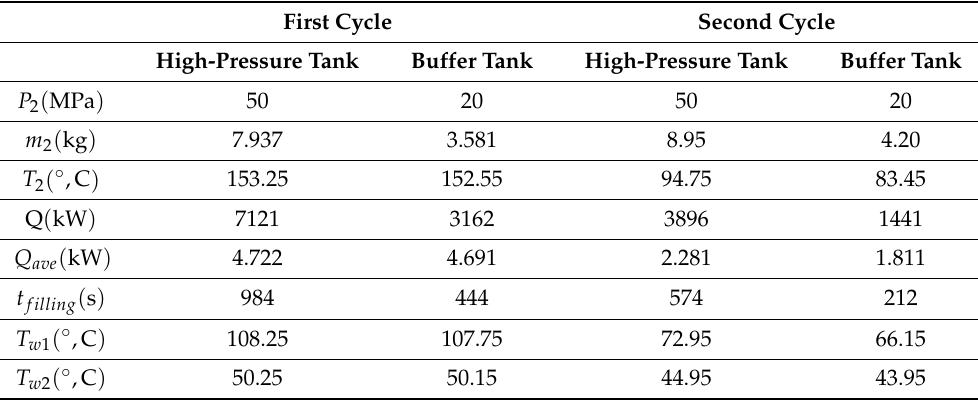
Table 3. Analysis results of the cycles of hydrogen storage